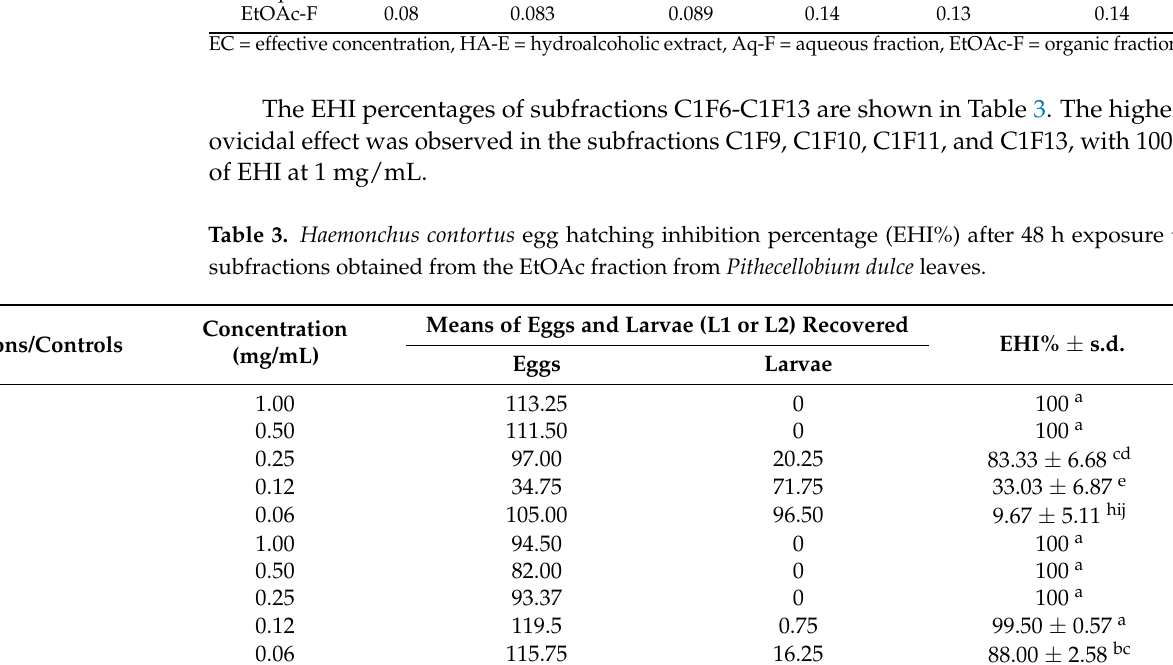
Table 2. Effective concentrations required to inhibit 50% and 90% of Haemonchus contortus egg hatching after 48 h exposure to a hydroalcoholic extract and two fractions from Pithecellobium dulce leaves. EC 50 Treatments (mg/mL)